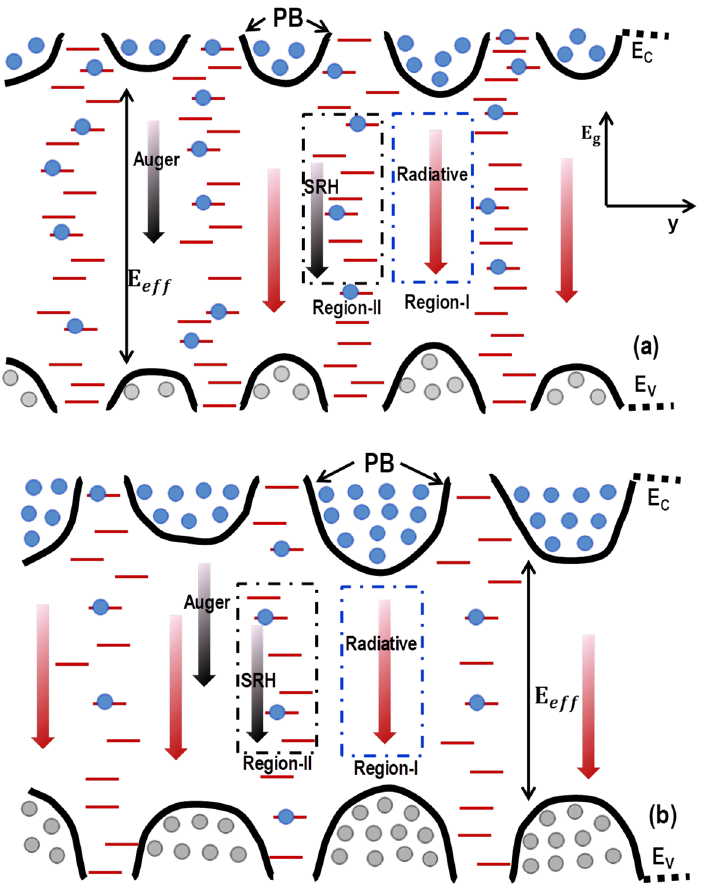
Figure 7. Schematic illustration of the proposed local in-plane fluctuation of potential energy in the quantum wells (QWs) for ( a ) #1 and ( b ) #4, where PB represents the potential barrier. Regions I and II represent the radiative recombination and the SRH process or carrier tunneling via point defects, respectively.